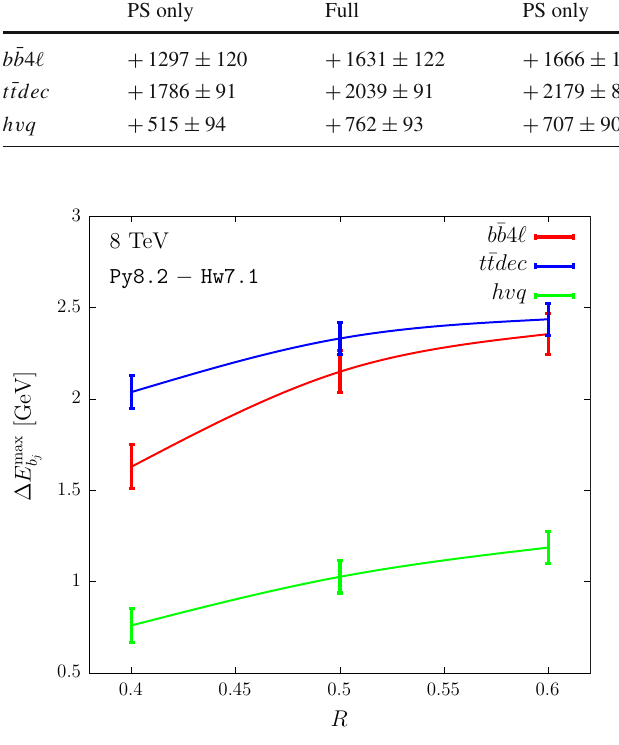
Fig. 16 Differences of E max between the Pythia8.2 and the b j Herwig7.1 showers, for the three generators, as a function of